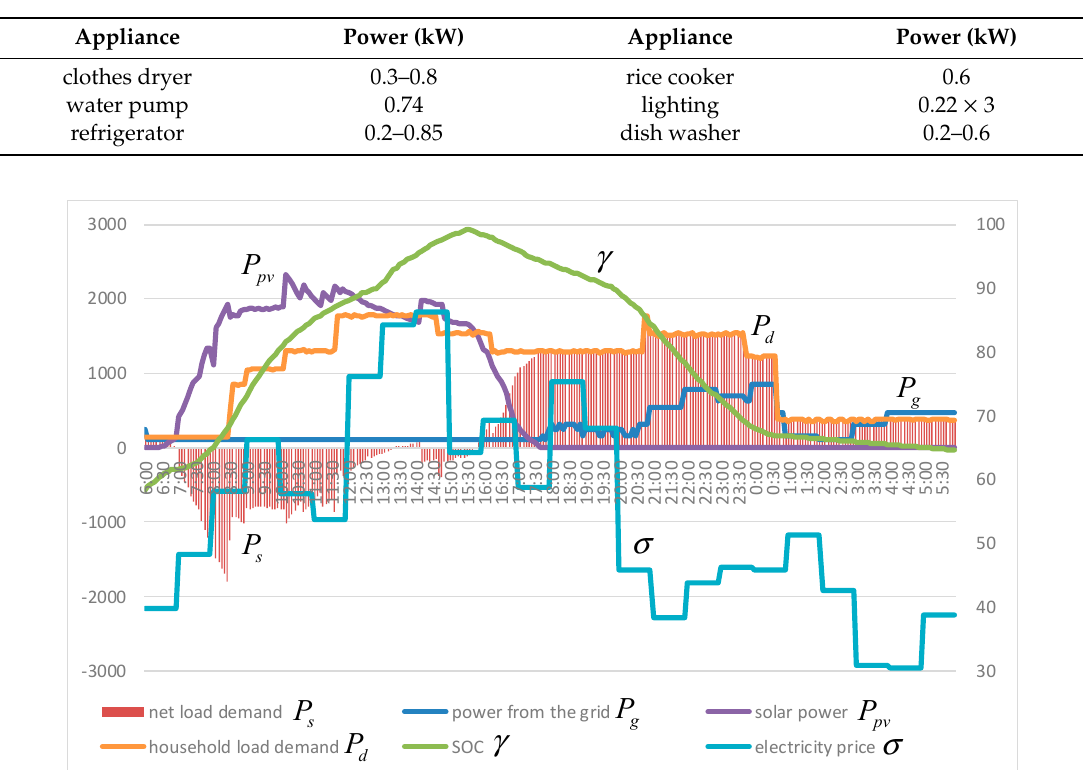
Table 1. Consumptions of Tested Appliances.